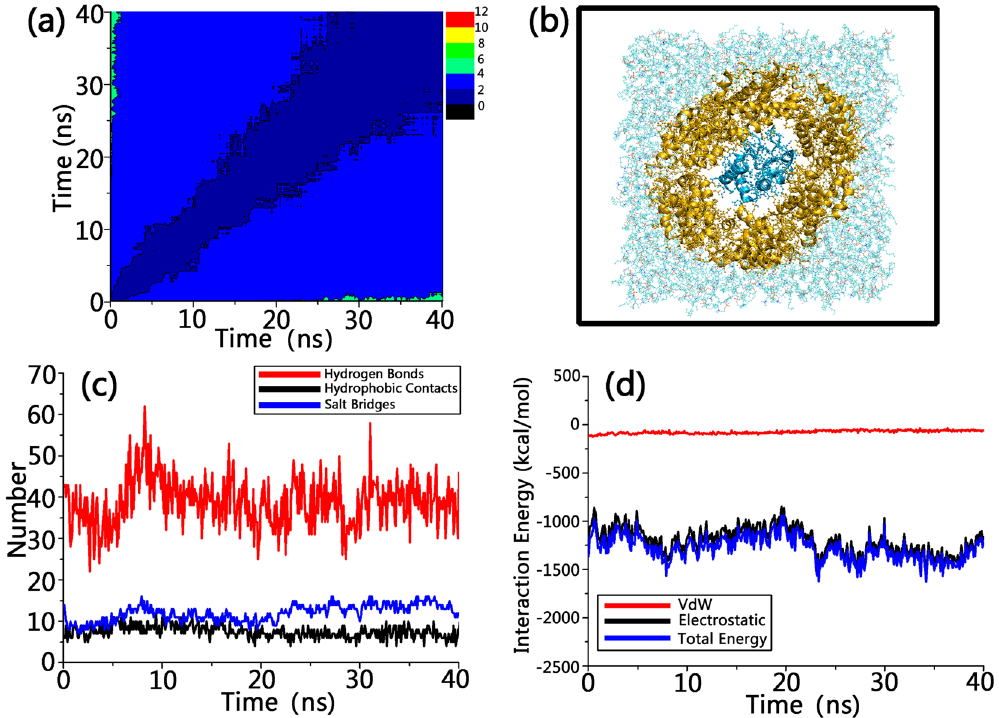
Figure 7. 2D RMSD matrix ( a ), snapshots ( b ), non-bonded analysis ( c ) and interaction energies ( d ) for the all- atom explicit-solvent simulations of the cytochrome C in the inner cavity of Bax oligomeric